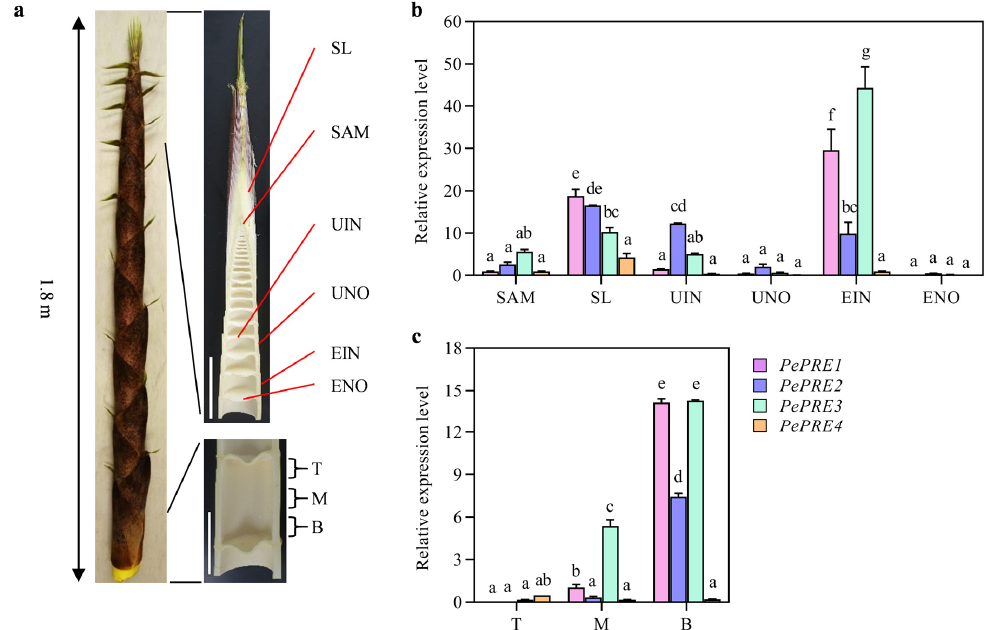
Figure 2. Expression pattern of PePRE s in the elongating bamboo shoot. ( a ) Structure of an elongating moso bamboo shoot. Samples are collected from a 1.8 m bamboo shoot. SAM, shoot apical meristem; SL, scale leaf; UIN, unelongated internode; UNO, unelongated node; EIN, elongating internode; ENO, elongating node. Scale bar represents 10 cm. ( b ) Expression levels of PePRE genes in the elongating bamboo shoot. ( c ) Expression levels of PePRE genes in different parts of an elongating internode. T, top part; M, middle part; B, bo tt om part. Di ff erent le tt ers above the data columns indi- cate signi fi cant di ff erences ( p < 0.05; Duncan’s test).